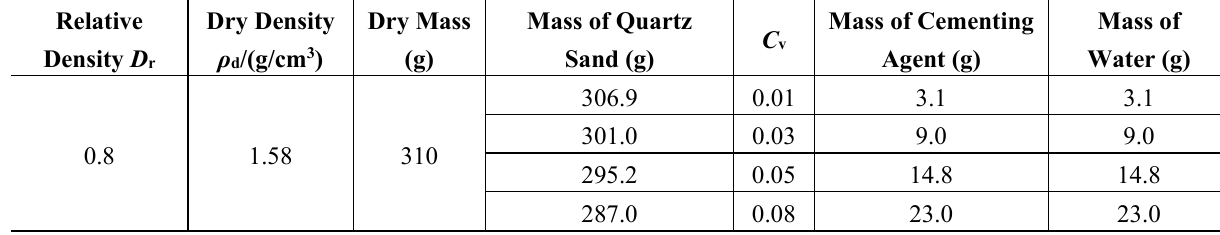
Figure 3. Sample of artificial cemented sand. Table 2. Parameters of cemented sand samples.